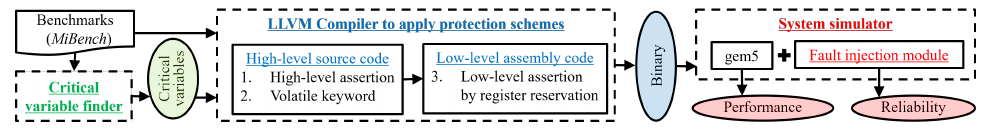
Figure 4. Our experimental setup to prove the efficacy of critical variable protection